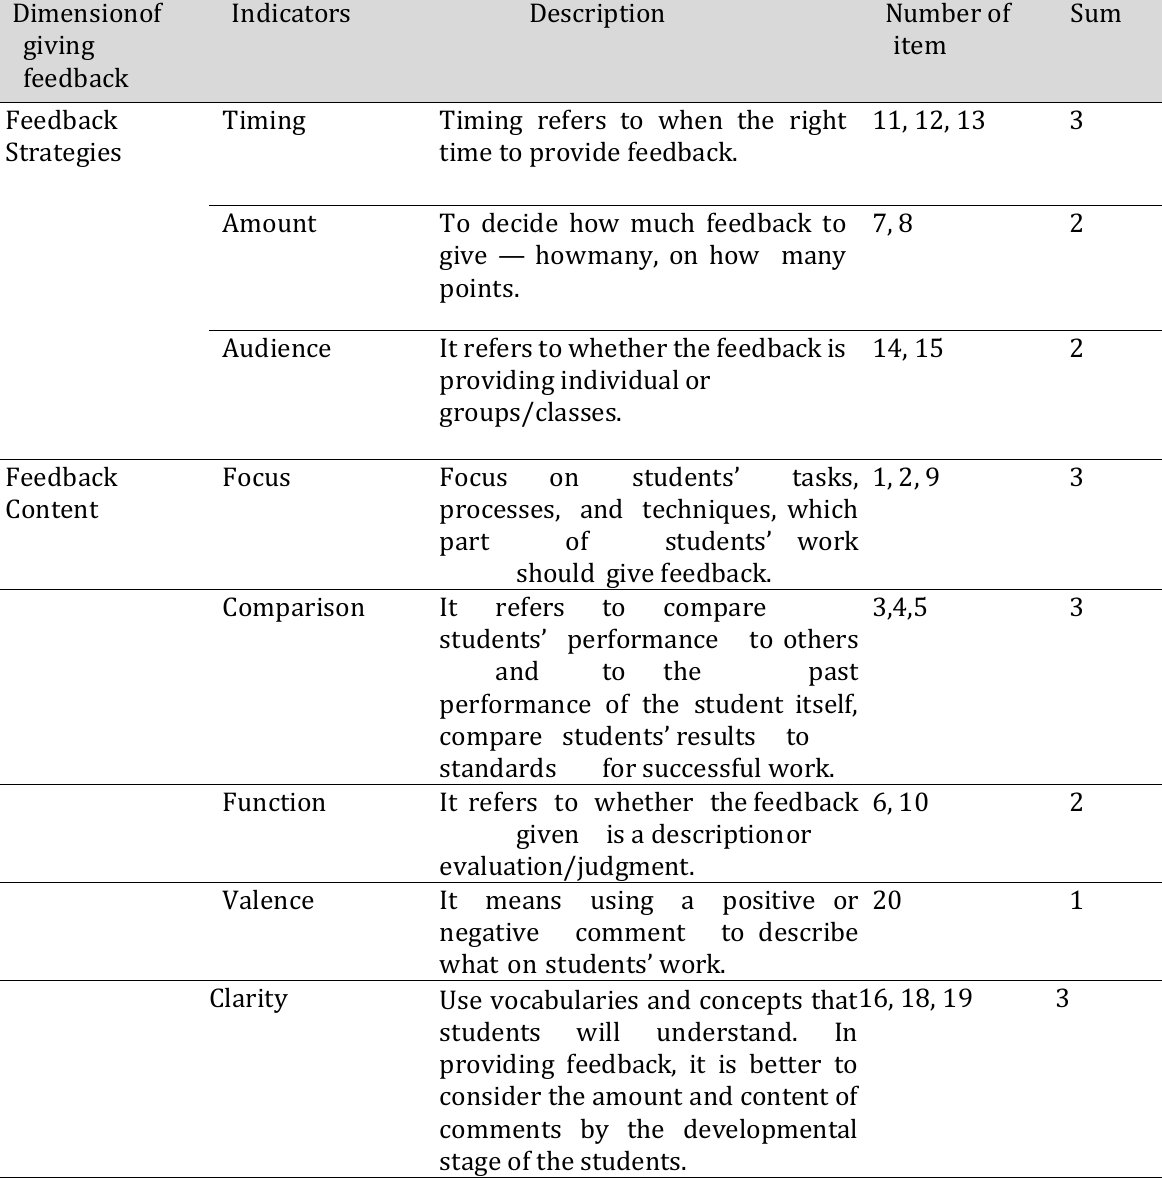
Table 1. The questionnaire grille of the teacher’s oral